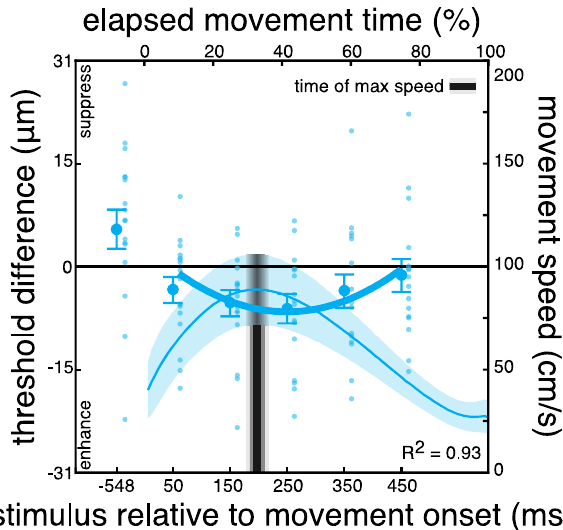
Figure 4. Results of Experiment 3. Differences in detection thresholds between baseline and reaching blocks on the static, target hand. Somatosensory sensitivity is generally improved during movement, but this was systematic only around the time of maximal speed of the moving hand. Details as in Fig.